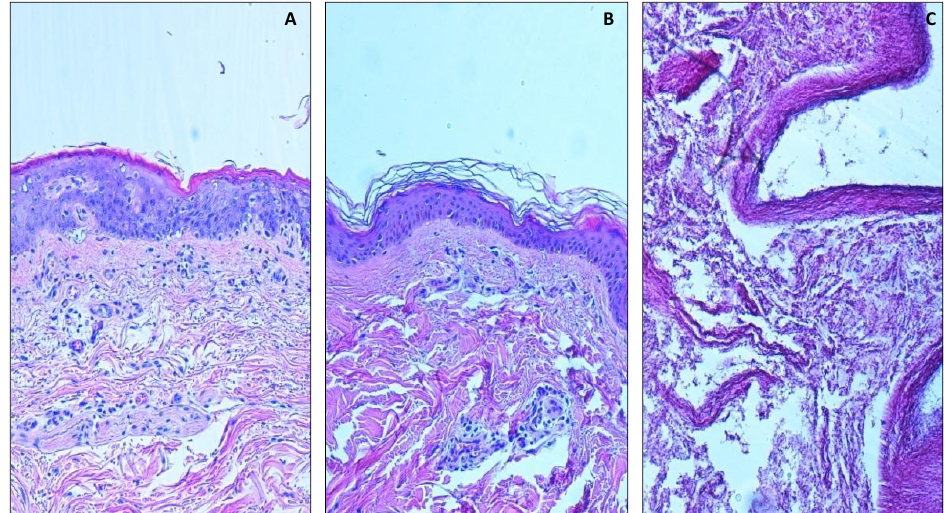
Figure 1. Morphological analysis of skin. ( A , B ) Image shows well preserved skin 15 days after death, 10×. ( C ) Disgregated skin 2 years after death, 10×.